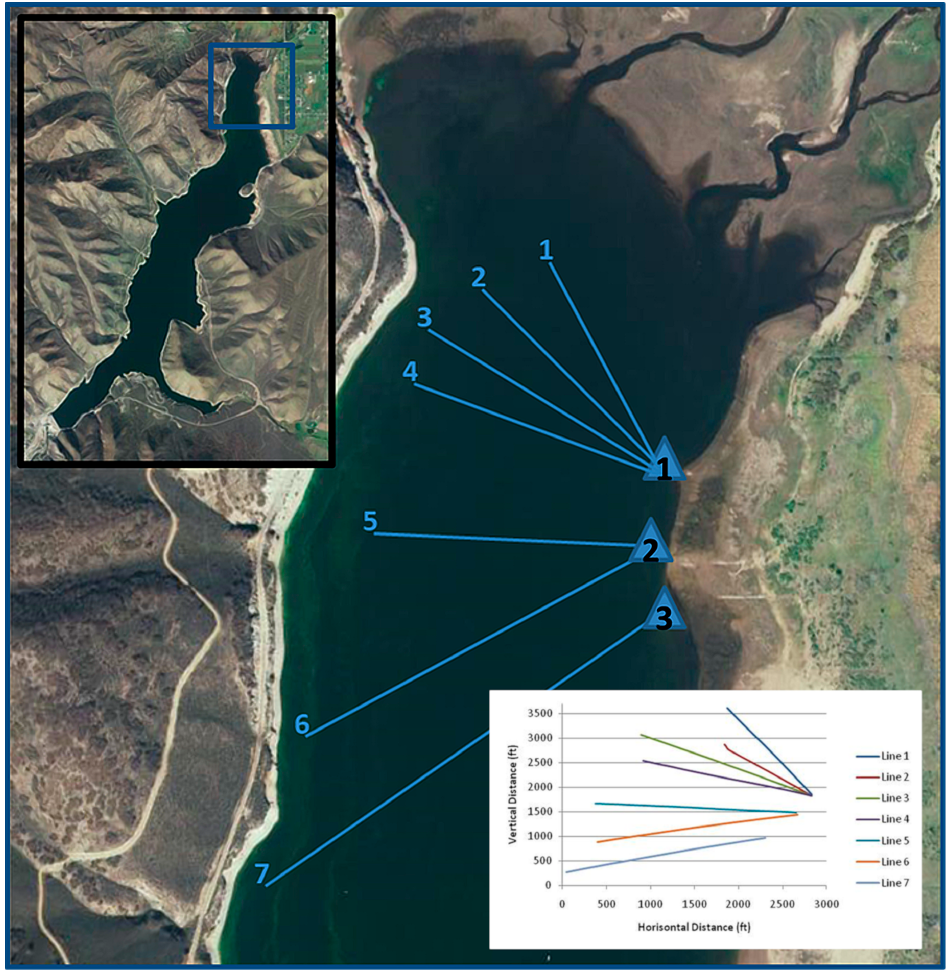
Figure 4. Example raw sonar data from Odom eChart software for a survey line showing a channel on the left side. The bottom shows as multiple sonar returns with significant noise.